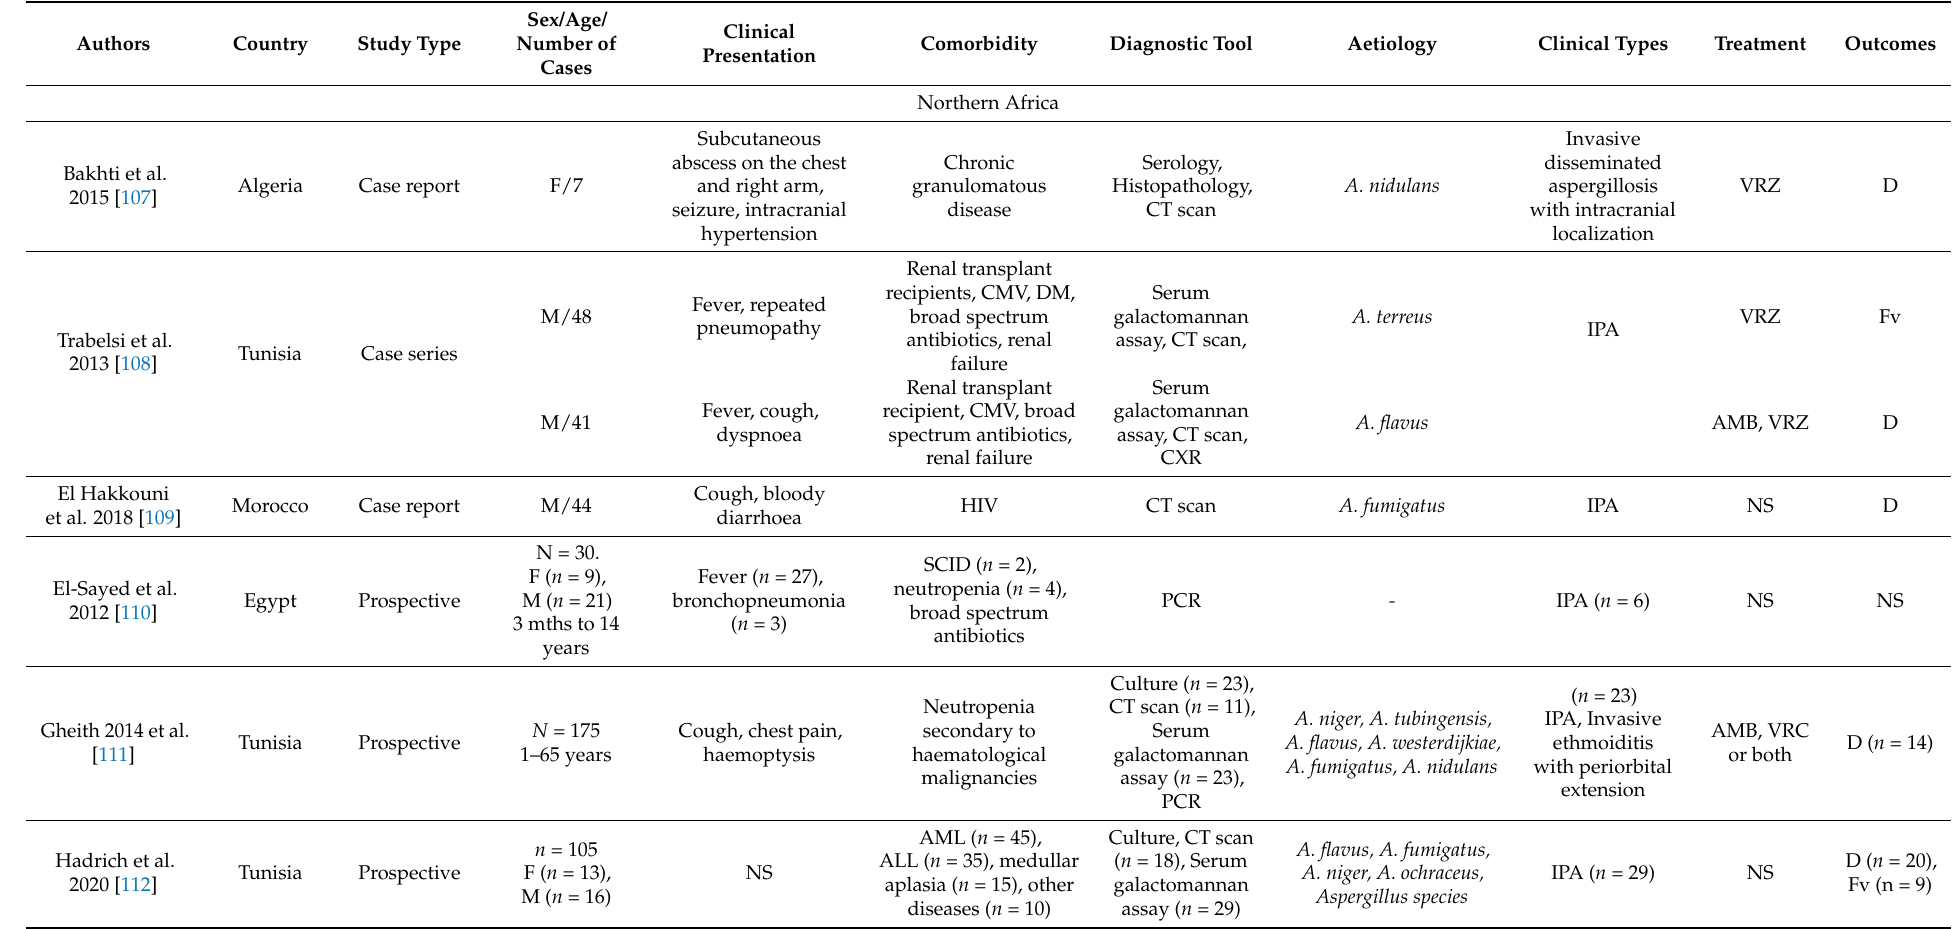
Table 4. Cases of IA that have been reported from